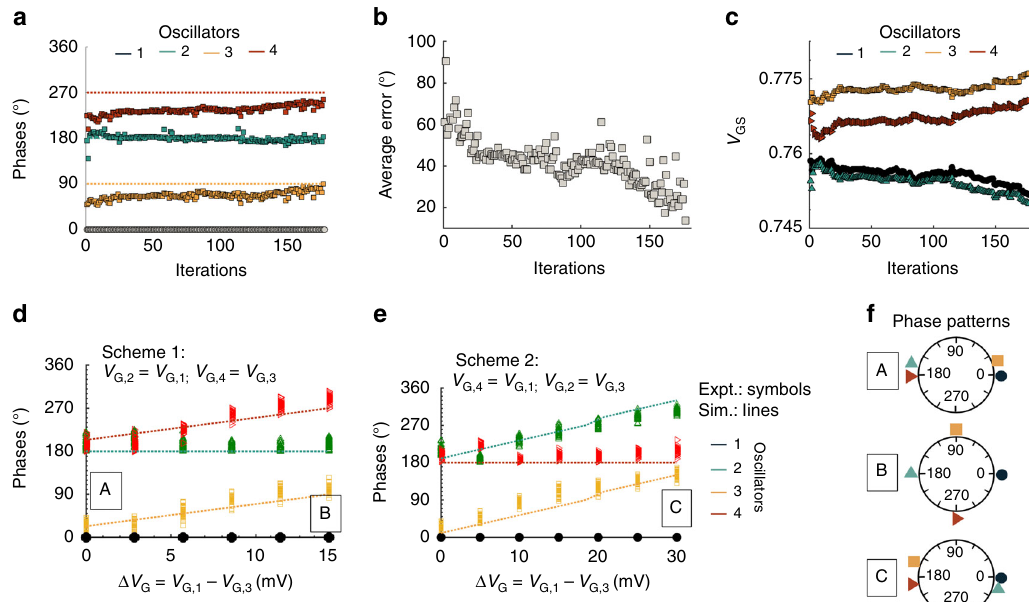
Fig. 3 Simulation phase patterns showing the evolution of the insulator-to-metal phase-transition nano-oscillators (IMT-NO) from an initial condition towards the desired phases (shown by dotted lines in the fi gure). The feedback signal considered here is the error between the current and desired phase pattern. The corresponding V G ’ s are modulated based on this feedback error signal (see Method for details). b , c ) show evolution of the error in the phase pattern and V G ’ s of the oscillators. d , e Illustration of two phase-modulation schemes governed by the difference between the gate biases Δ V G of oscillator 1 ( V G,1 ) and oscillator 3 ( V G,1 ). In scheme 1, V G,2 = V G,1 and V G,4 = V G,3 , while in scheme 2, V G,2 = V G,3 and V G,4 = V G,1 . The experimentally obtained phase differences among the oscillators (shown by symbols) for different Δ V G s are in excellent agreement with the simulation results (shown by dotted lines). f Three representative phase patterns (A, B, and C) obtained from schemes 1 and 2 are also in their natural frequencies, compared to the coupling strength, the network becomes unsynchronized as seen for higher values of Δ V G .